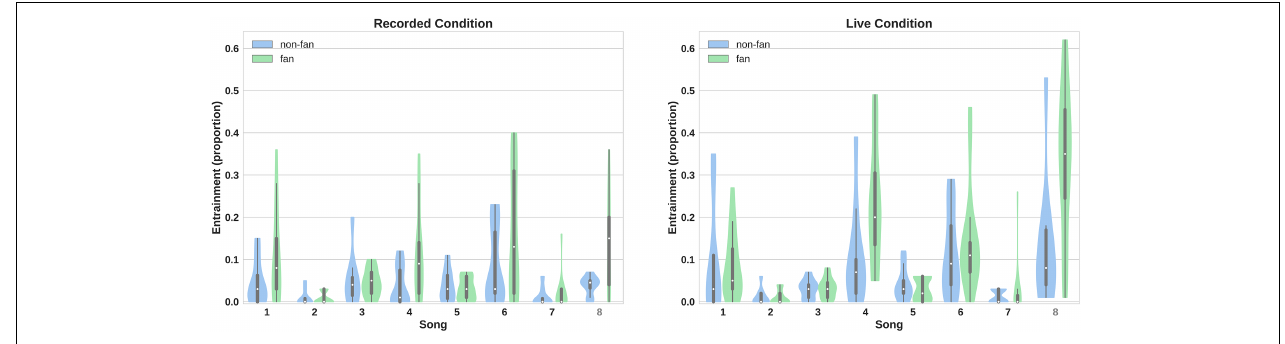
FIGURE 2 | Proportion of movement entrainment across songs. Fans generally showed a higher degree of entrainment to the tempo of the music than Neutral-listeners. However, there was variation among songs, which interacted with Concert-status. The songs were: (1) “Just to Know I Can”; (2) “How Long”; (3) “Fool”; (4) “Elouise”; (5) “Frozen Pond”; (6) “Feel”; (7) “Secrets”; and (8) reinterpretation of “Blown Wide Open.” The violin plots show the same parameters as a standard box plot (range, interquartile range and median) as well as a kernel density plot that estimates the continuous distribution of the